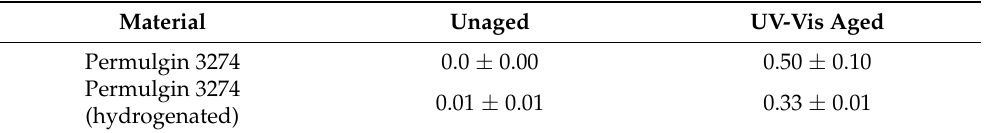
Table 4. Total acid number before and after the UV-vis ageing experiment. The data are expressed as mean ± standard